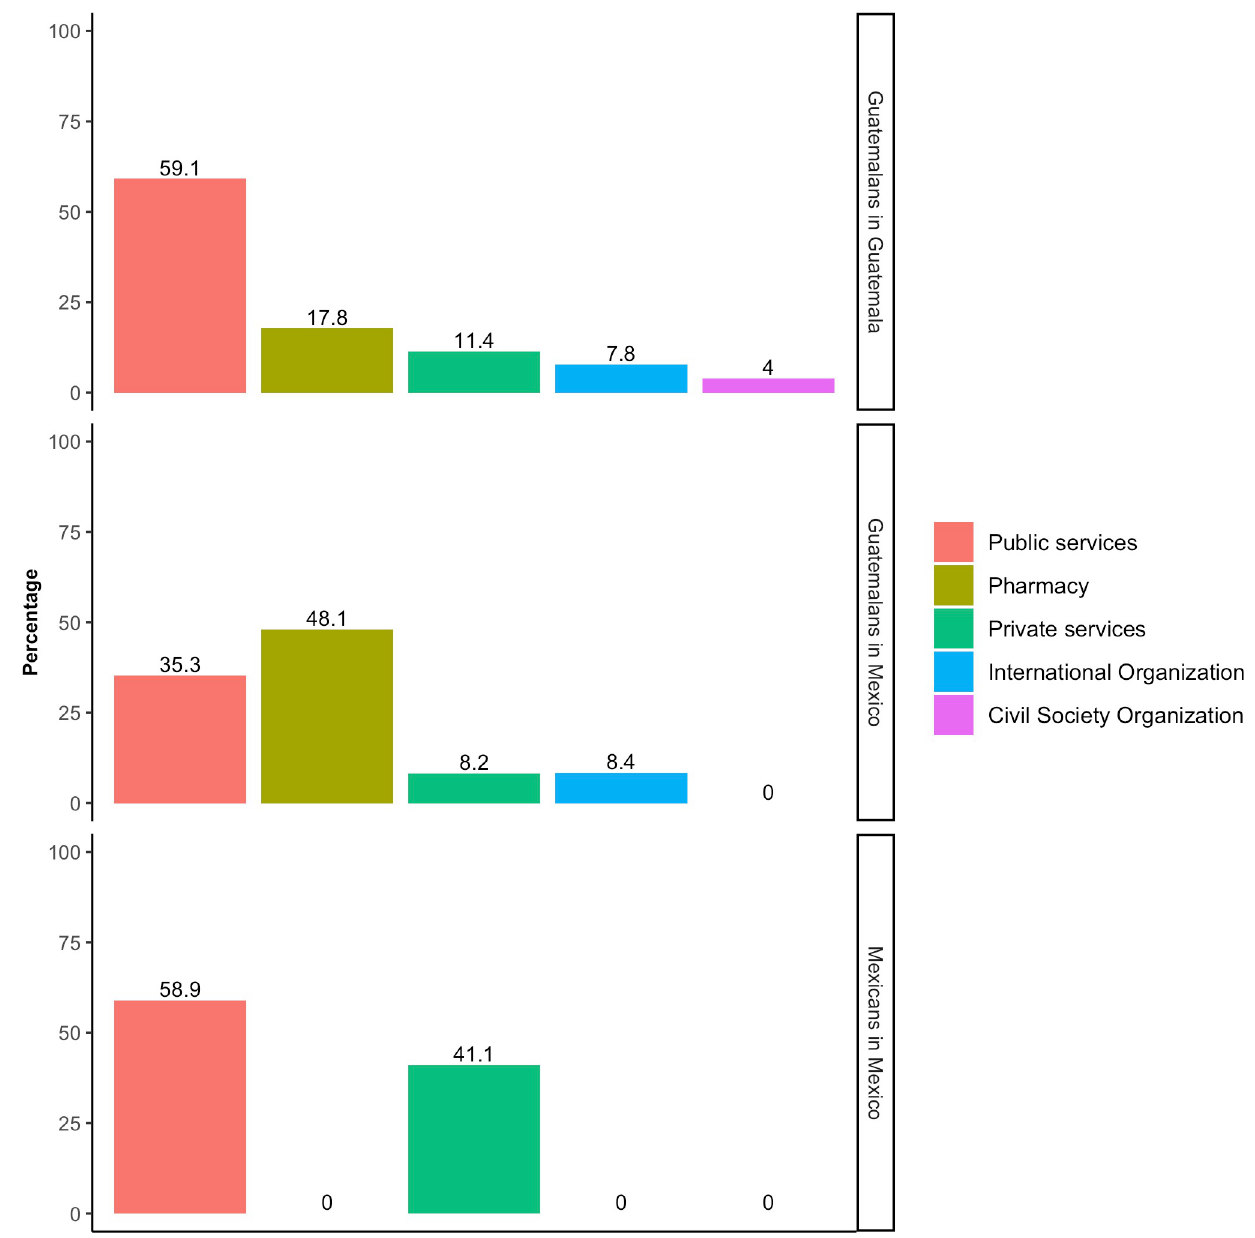
Fig 3. Type of health service used, by mobility